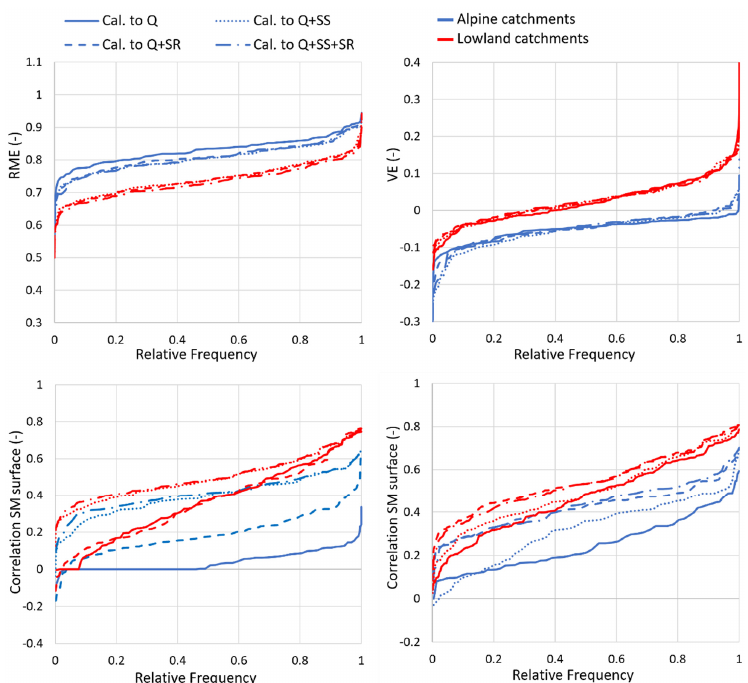
Figure 3. Cumulative distribution functions (CDFs) of the values of the runoff model efficiency (top left), runoff volume error (top right), and correlation coefficients between the simulated and measured surface soil moisture (bottom left) and root soil moisture (bottom right) in the calibration period 2007–2014. CDFs are plotted for the four calibration variants. The red and blue lines show the calibration variants for the group of 138 Lowland (red) and 71 Alpine catchments (blue), respec- tively. From the CDFs of the correlation coefficients between the simulated and measured soil moisture both in the surface and root soil layers, it is evident that in the case of the calibration only for the runoff, the values of the correlation coefficients are very low in the